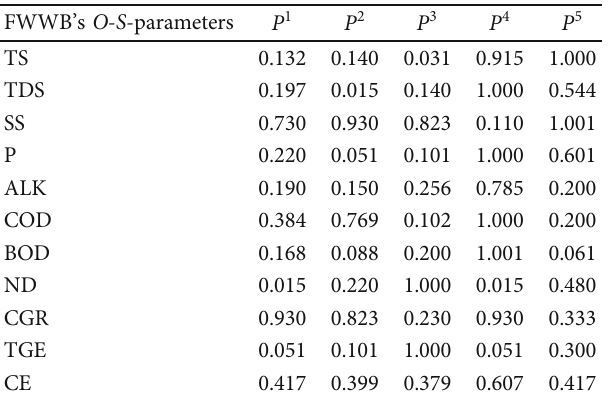
Table 8: Computed values of S corresponding to FWWB points.